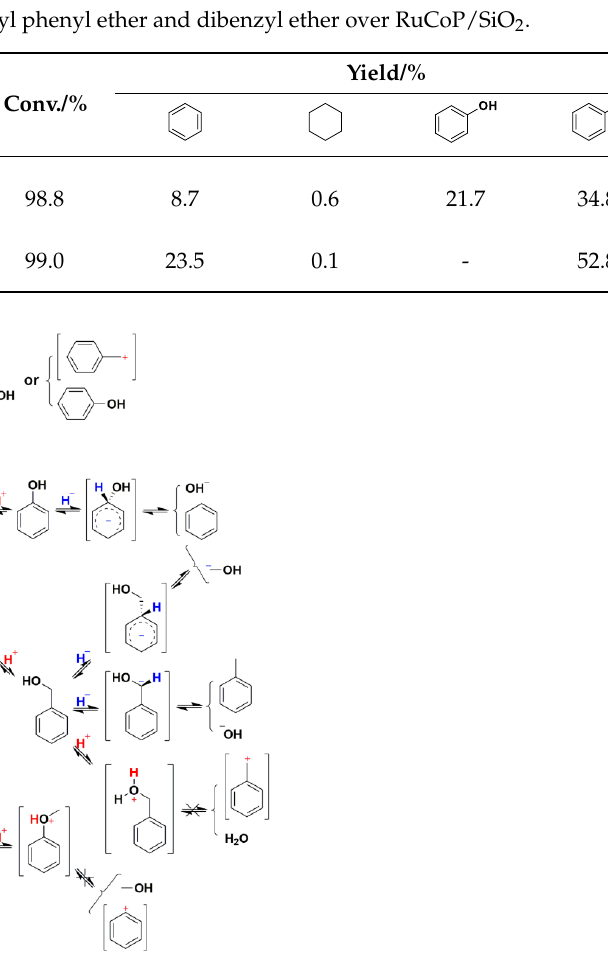
2 . Table 3. Hydrogenolysis of benzyl phenyl ether and dibenzyl ether over RuCoP/SiO 2 .